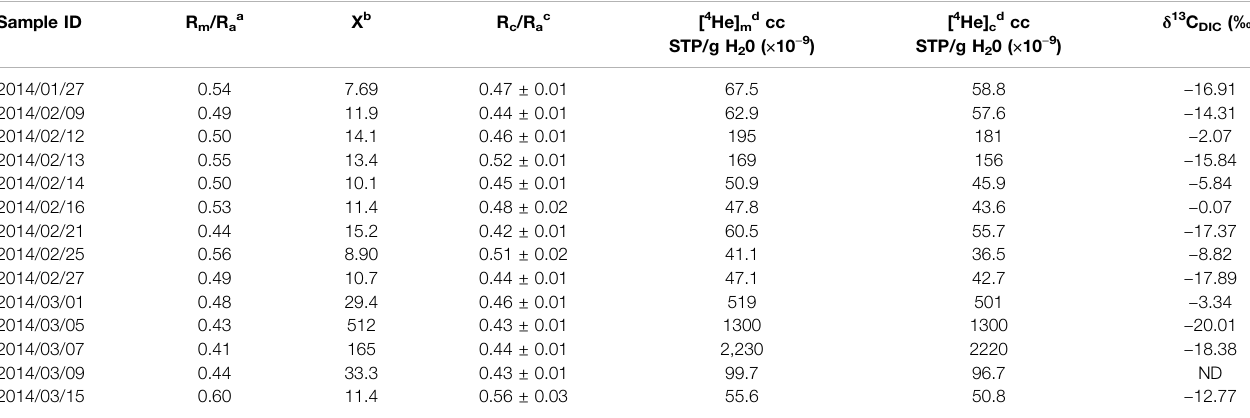
TABLE 2 | Helium isotope and relative abundance characteristics from January 20 to March 21, 2014. Sample